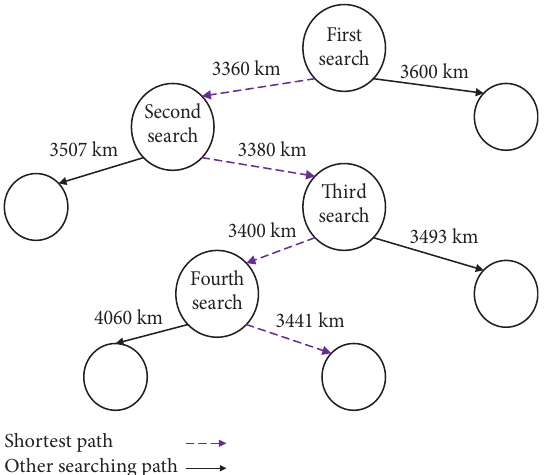
Figure 14: Search path F ( n ) from Madrid to